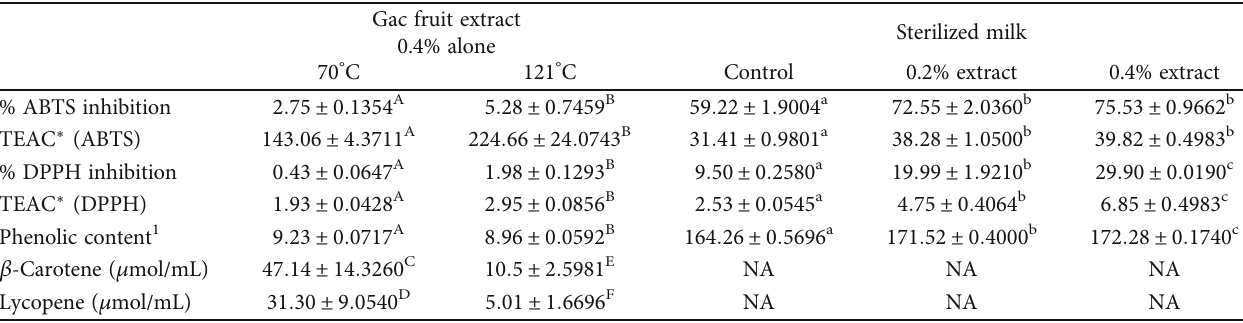
Table 1: Phenolic contents, β -carotene contents, lycopene contents, and antioxidant activities of Gac fruit extract and sterilized milk supplemented with Gac fruit extract.